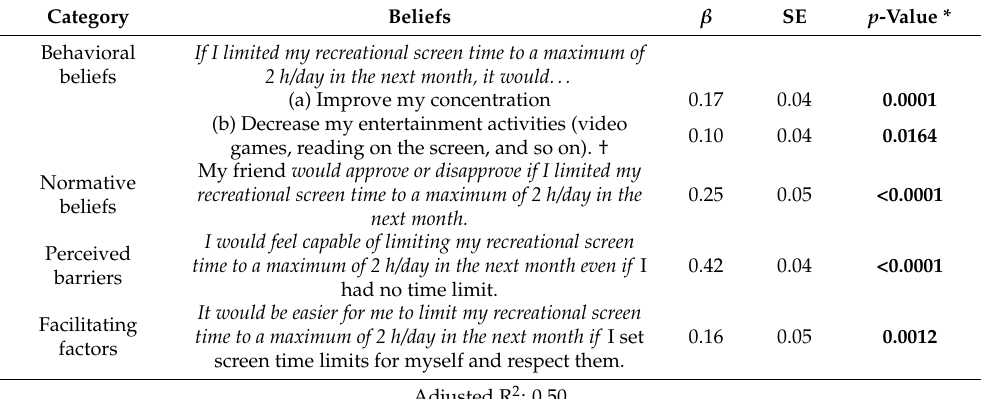
Table 5. Beliefs associated with the intention to limit recreational screen